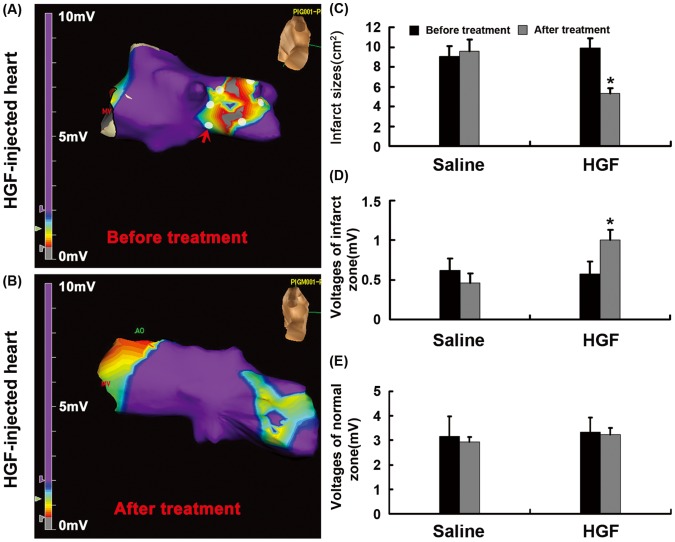
Infarct size and myocardial voltage.(A), (B) the left ventricular geometry before and after the GTx. Gray and purple respectively indicates the myocardial infarct and normal zones; the region between gray and purple is transitional zone. Red arrow indicates injected site marked with white dots. (C) Bar graph showed the infarct sizes significantly reduced in the HGF-injected hearts after GTx than those before GTx. (D), (E) Bar graph explained the myocardial voltage levels in the infarct and normal zones of HGF-injected hearts. There were significantly higher myocardial voltage levels in the infarct zone of HGF-injected hearts after GTx than those before GTx. *P<0.01 vs. before GTx in HGF group.